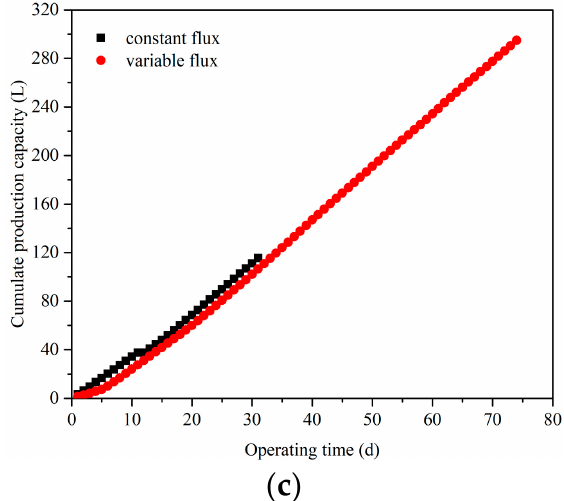
Figure 2. Variations of transmembrane pressure (TMP) ( a , b ) and cumulate production capacity ( c ) at different operating modes of water flux. ( a ) Constant flux mode; ( b ) varying flux mode.